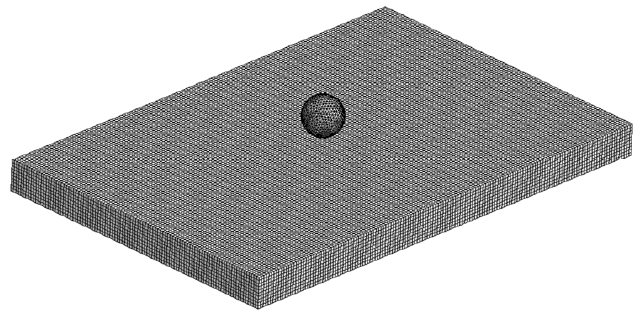
Figure 5. Finite element model representing the impact test.